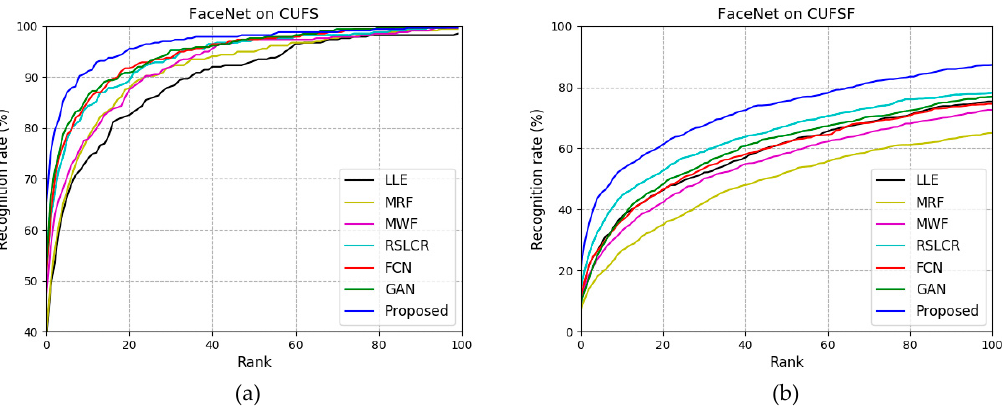
Figure 6. Face sketch recognition accuracies of FaceNet on the CUFS ( a ) and the CUFSF ( b )